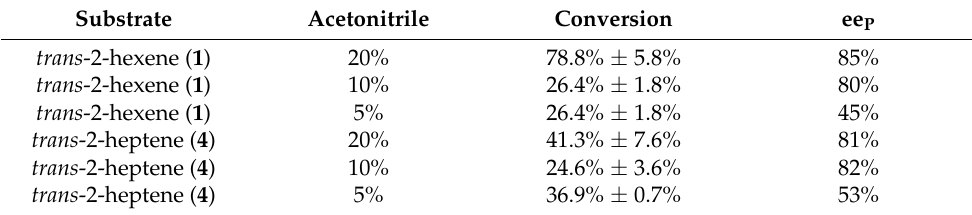
Table 1. Conversion and product enantiomeric excess (ee P ) obtained in the Shi epoxidation of alkenes 1 and 4 at different acetonitrile concentrations. The epoxidations were carried out at a 20 mL scale, and K 2 CO 3 was used to maintain the pH at 11; 0.2 equivalents of the Shi epoxidation catalyst and 4 equivalents of Oxone© were used in the conversion of 50 mM substrate. Substrate Acetonitrile Conversion ee